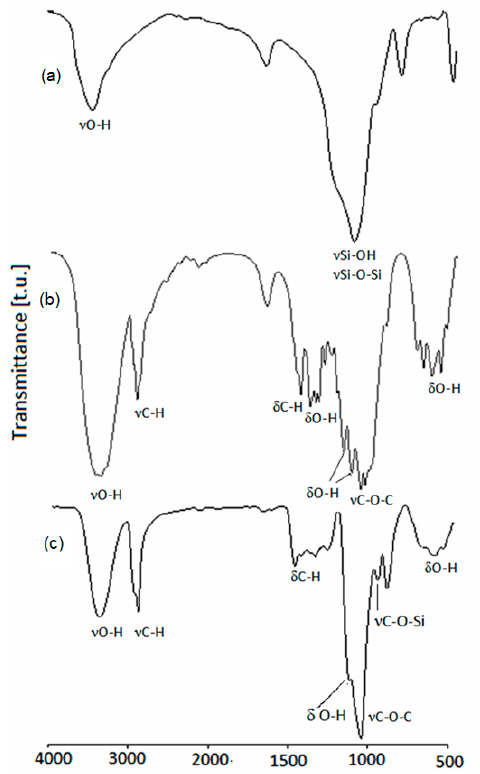
Figure 1. IR spectrum of MSA ( a ), CEL ( b ), and polyol ( c ).